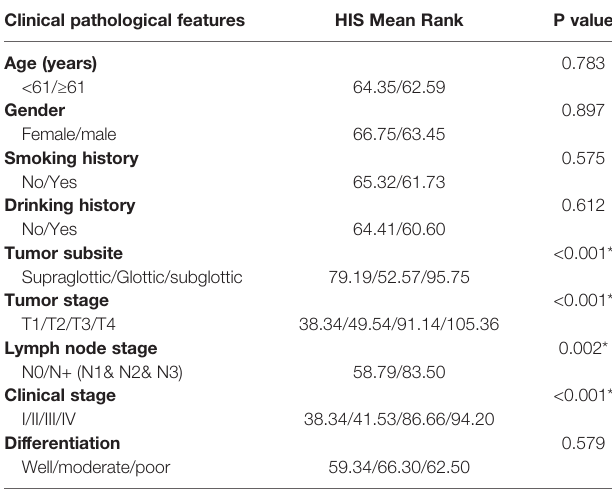
TABLE 2 | The relationship between DIAPH1 expression and clinical pathological features in 126 LSCC patients (*p<0.01). Clinical pathological features